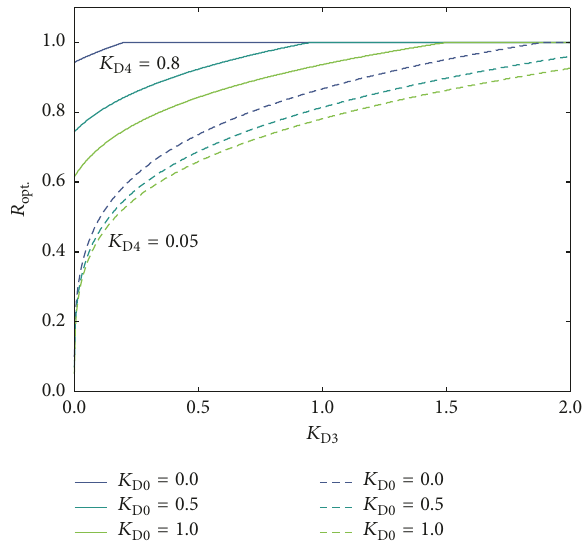
Figure 13: The optimum actuator size ratio 𝑅 maximum hydraulic power density (1/𝑅)𝐶 function of the two coefficients 𝐾 the static drop coefficient 𝐾